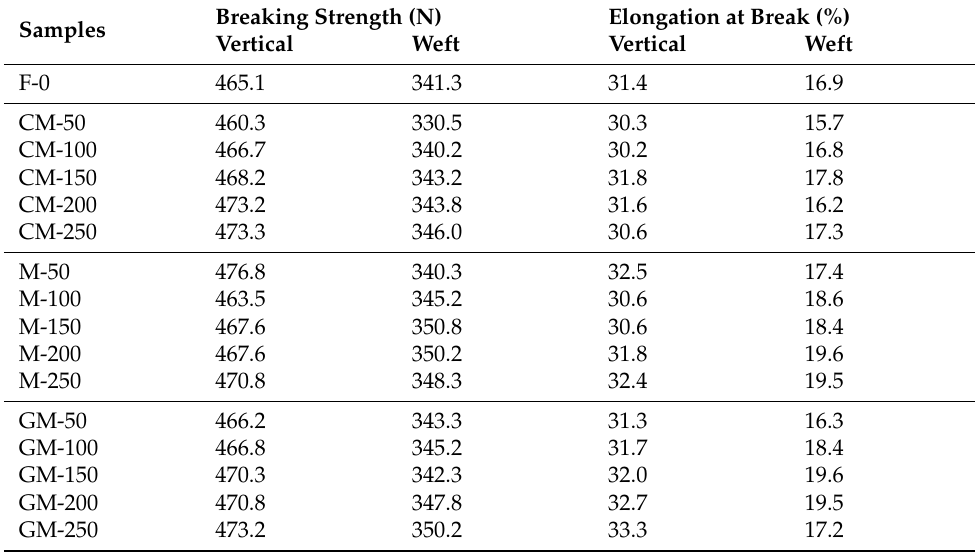
Table 7. The flame retardant property of the